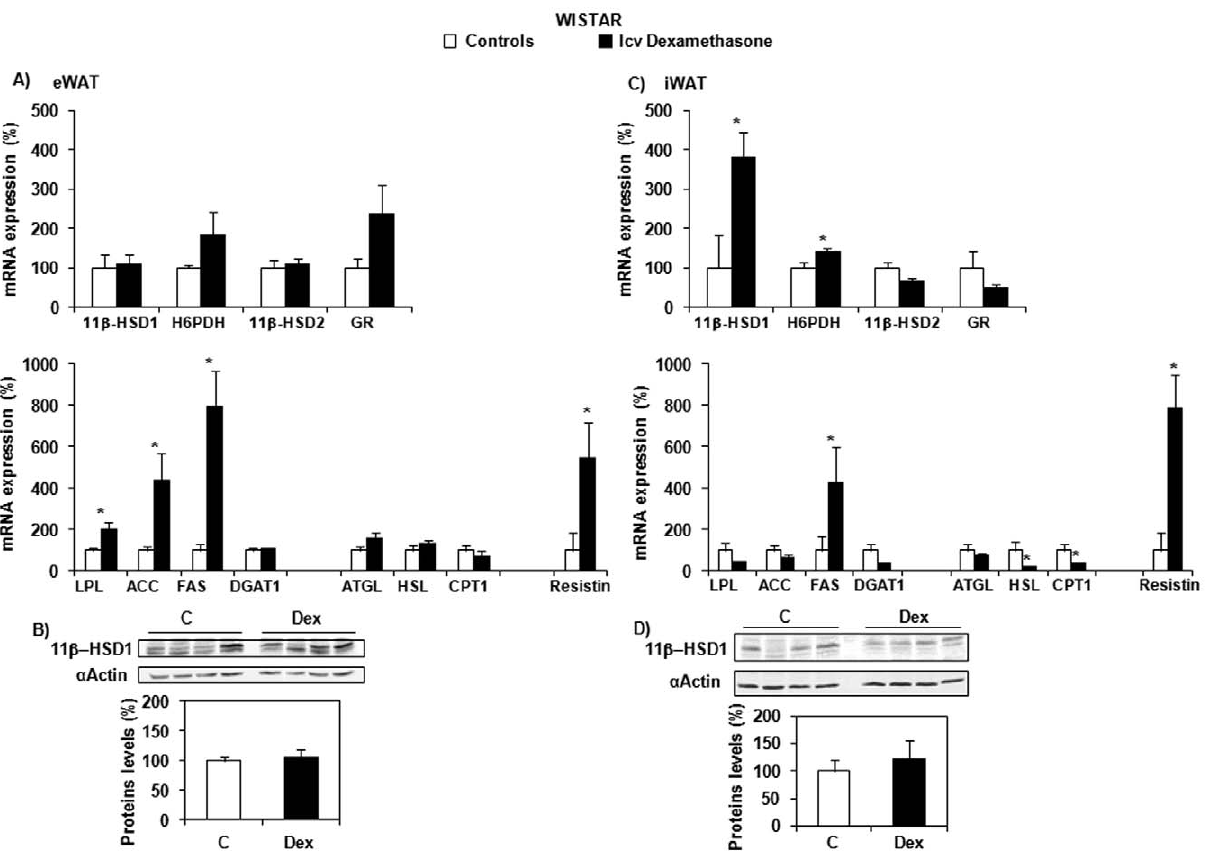
Figure 2. mRNA and protein expression of different markers of GC and lipid metabolism in Wistar rats. Effect of central (icv) dexamethasone infusion for 3 days in epididymal (eWAT) and inguinal (iWAT) white adipose tissue. A and C) Results are expressed as percent of relative mRNA expression compared to that obtained in control rats (100%). The analysis was performed in duplicate and the results were normalized with RPS29 expression. Mean 6 SEM of n =7 rats per group. * P , 0.05 compared to vehicle-infused control rats (Student’s t test). B and D) Representative Western blots of 11 b -HSD1 (n=4–5 per group). Quantification was performed using the ChemiDoc TM XRS and the Quantity One TM software.